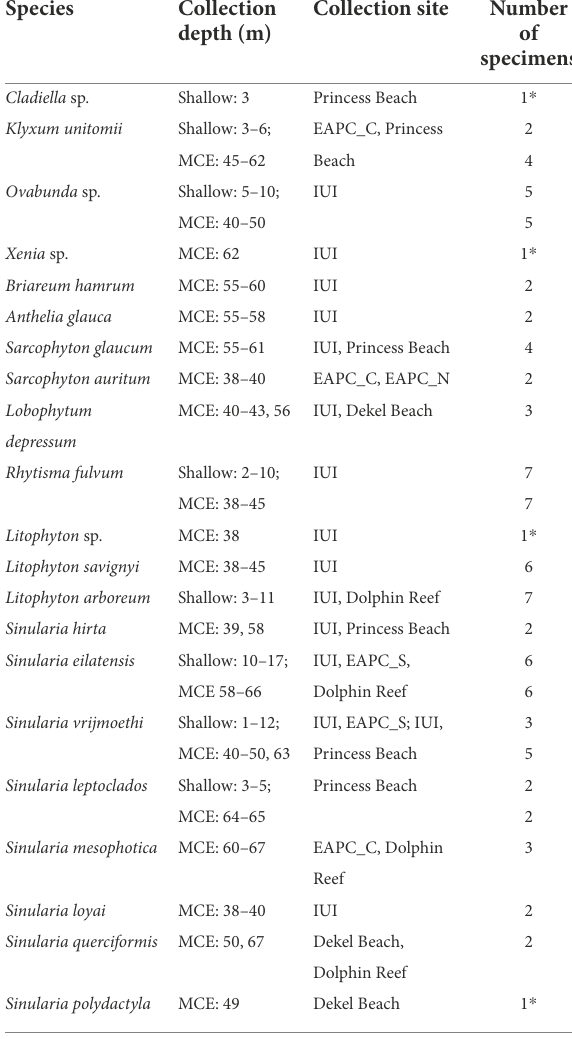
TABLE 1 List of octocoral taxa used in the study, their collection depth, site, and total number of samples from shallow reefs and mesophotic coral